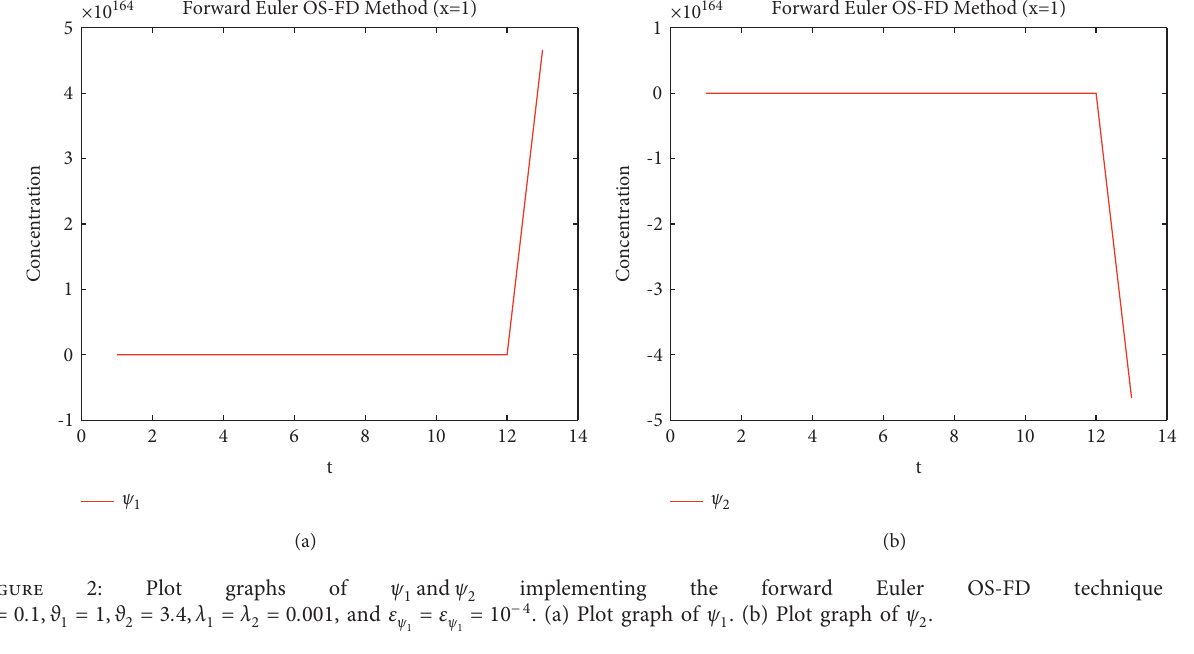
2: Plot graphs of ψ